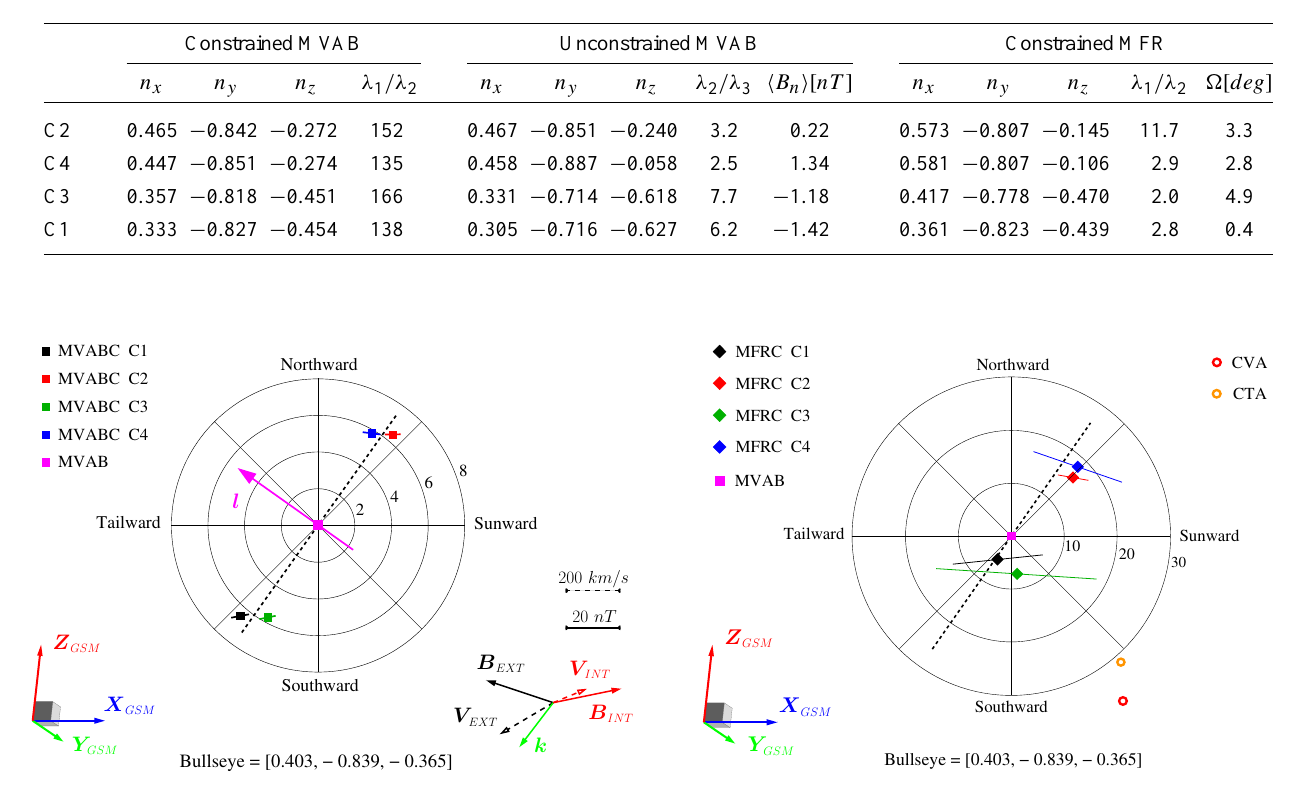
Fig. 4. Polar plot having the same reference direction as Figure 3 for an increased angular range. It shows the orientation of the individual normals provided by the constrained MFR technique (rhombs), the CVA (red open circle), and CTA (golden open circle) normals, provided by the planar timing analysis. The plane of the normals (see text) is indicated with a dashed line. erage, h n i MVAB , taken as reference direction (the magenta square at the center, symbol MVAB). The vertical line is ori- ented along the h n i MVAB × X GSE direction (roughly along the south-north direction) and the horizontal line completes the cartesian frame. The components of h n i MVAB in the GSE ref- erence frame are indicated at the bottom. Its orientation with respect to the GSM reference frame can be judged by looking at the unit vectors on the bottom left part of the figure. The circles designate directions of equal inclination with respect to h n i MVAB , in degrees. For each individual normal, an error bar is drawn, indicating the orientation uncertainty due to the statistical errors (see Sonnerup and Scheible,